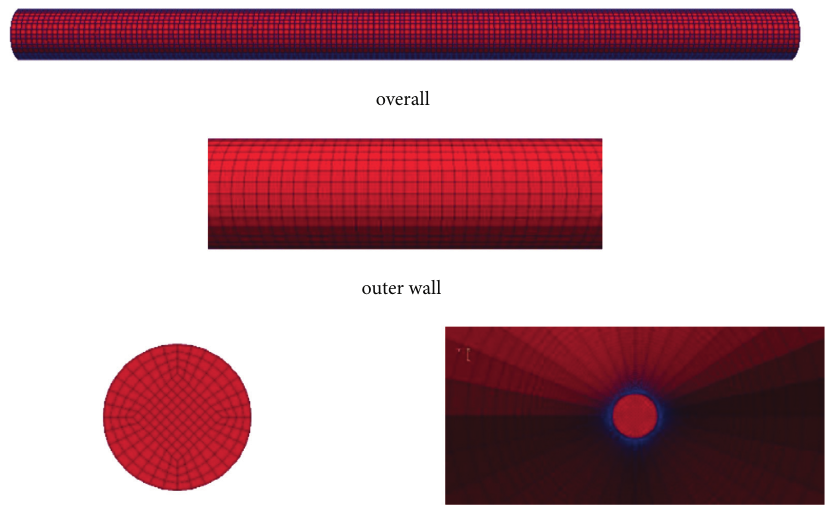
Figure 1: Mesh partition.